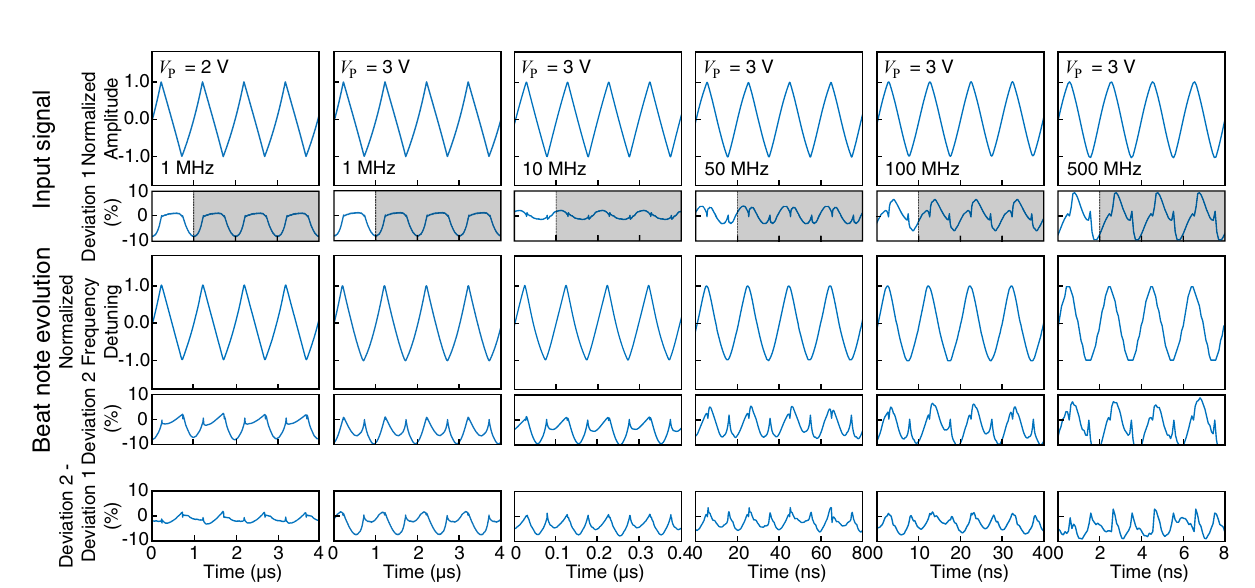
Fig.6|Characterizationofthelinearityoflaserfrequencymodulation. The fi rst row shows the recorded waveform of the electrical signal used to drive the phase shifter, togetherwith its deviation toaperfecttriangularwaveform (induced by an RF ampli fi er) de fi ned as Deviation 1. Because of the periodicity of the signal, Deviation1isfullyrepresentedwithinonemodulationperiod,whichisobtainedby averaging it over multiple modulation periods to have a better accuracy. The